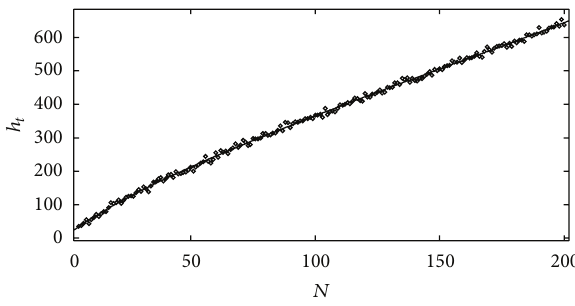
Figure 9: Relationship between ℎ 𝑡 and 𝑁 .